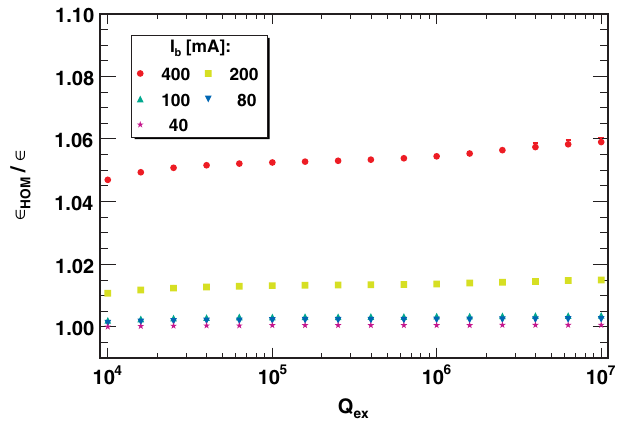
FIG. 23. Average longitudinal phase space increase and RMS caused by the TM mode error against the damping Q ex 010 ; 3 = 5 (cid:2) and TM mode and a chopped beam. Settings: passband 010 ; 2 = 5 (cid:2) ¼ 10 kHz , chopping pattern: 50 = 80 , N ¼ 10 , see modes, (cid:5) f HOM